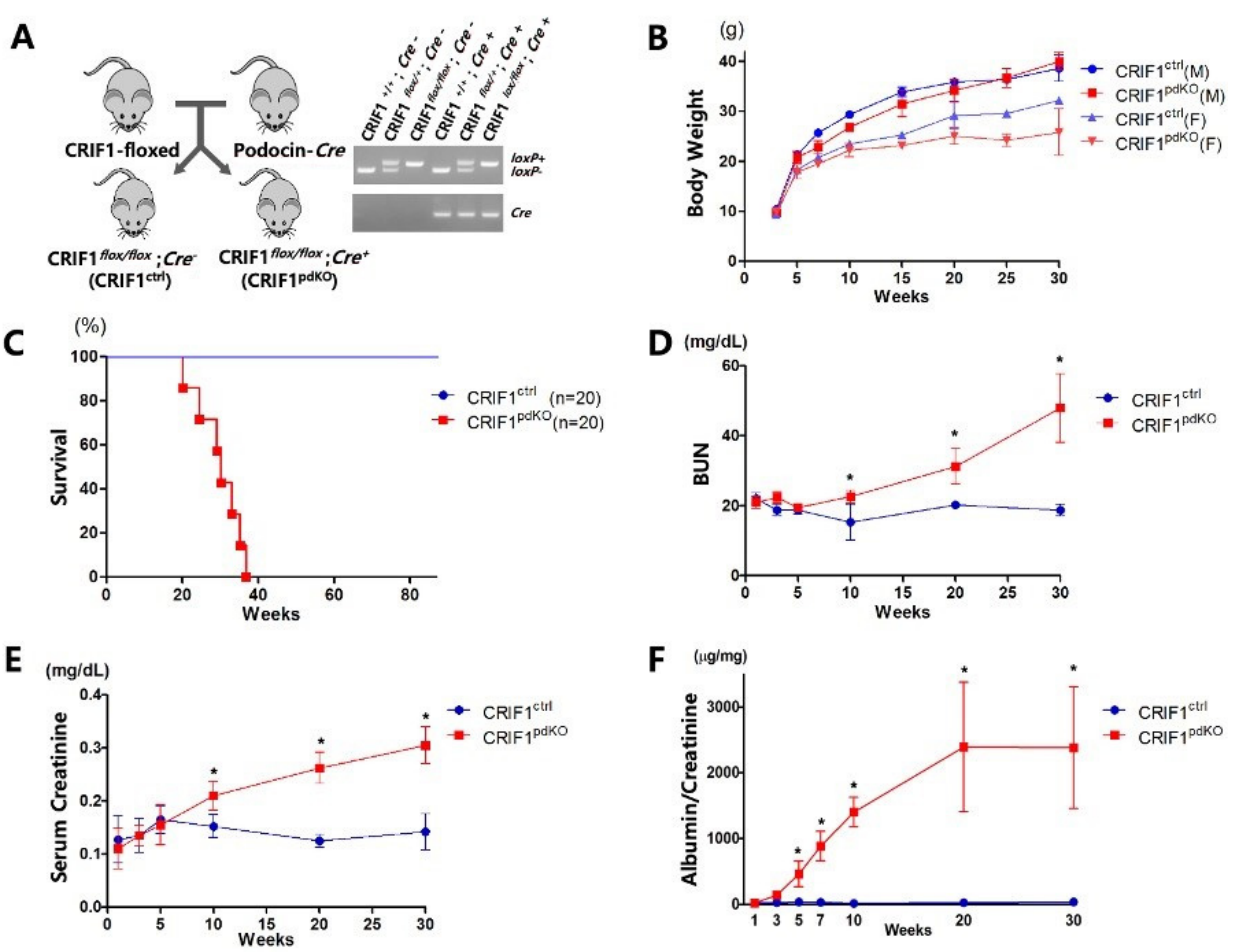
Figure 1. Podocyte-specific CRIF1 deficiency leads to massive albuminuria and azotemia in mice. ( A ) Podocyte-specific CRIF1 knockout mice were generated by crossing CRIF1 flox/flox mice with podocin-Cre mice. PCR analyses were performed to genotype the CRIF1-loxP alleles and Cre transgene. ( B ) Body weights of the male (M; n = 10) and female (F; n = 10) CRIF1 pdKO and CRIF1 ctrl mice, respectively. ( C ) Survival rates of the CRIF1 pdKO and CRIF1 ctrl mice ( n = 20 per group). ( D , E ) Blood urea nitrogen ( D ) and serum creatinine ( E ) levels in the CRIF1 pdKO and CRIF1 ctrl mice ( F ) albuminuria levels in the CRIF1 pdKO and CRIF1 ctrl mice ( B , D – F ) Data are represented as the mean ± SD. ( D – F ) * p < 0.05 by Student’s t